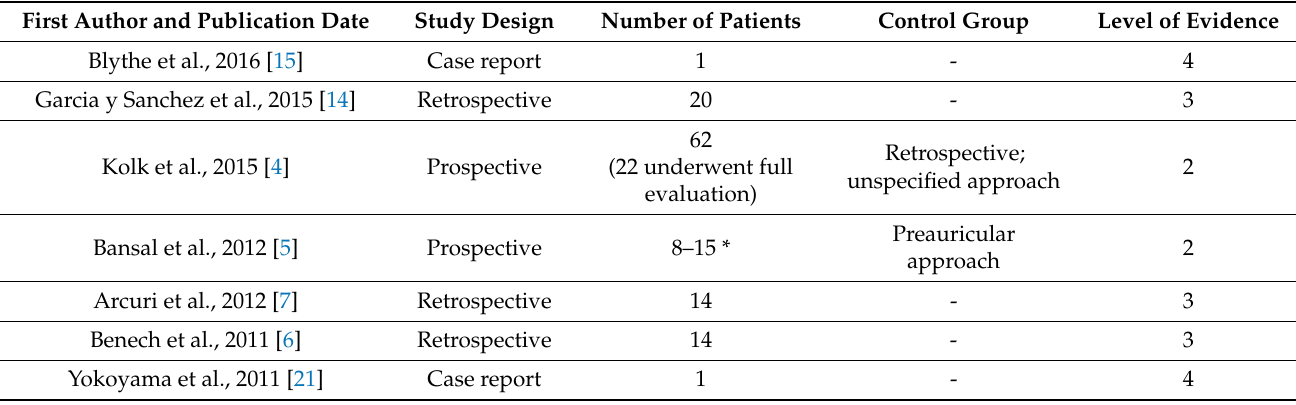
Table 4. Quality assessment. Description in the text. * The study involved 15 patients operated bilaterally, i.e., 30 approaches were performed, 15 of which were RA. The exact number of patients who underwent RA was not